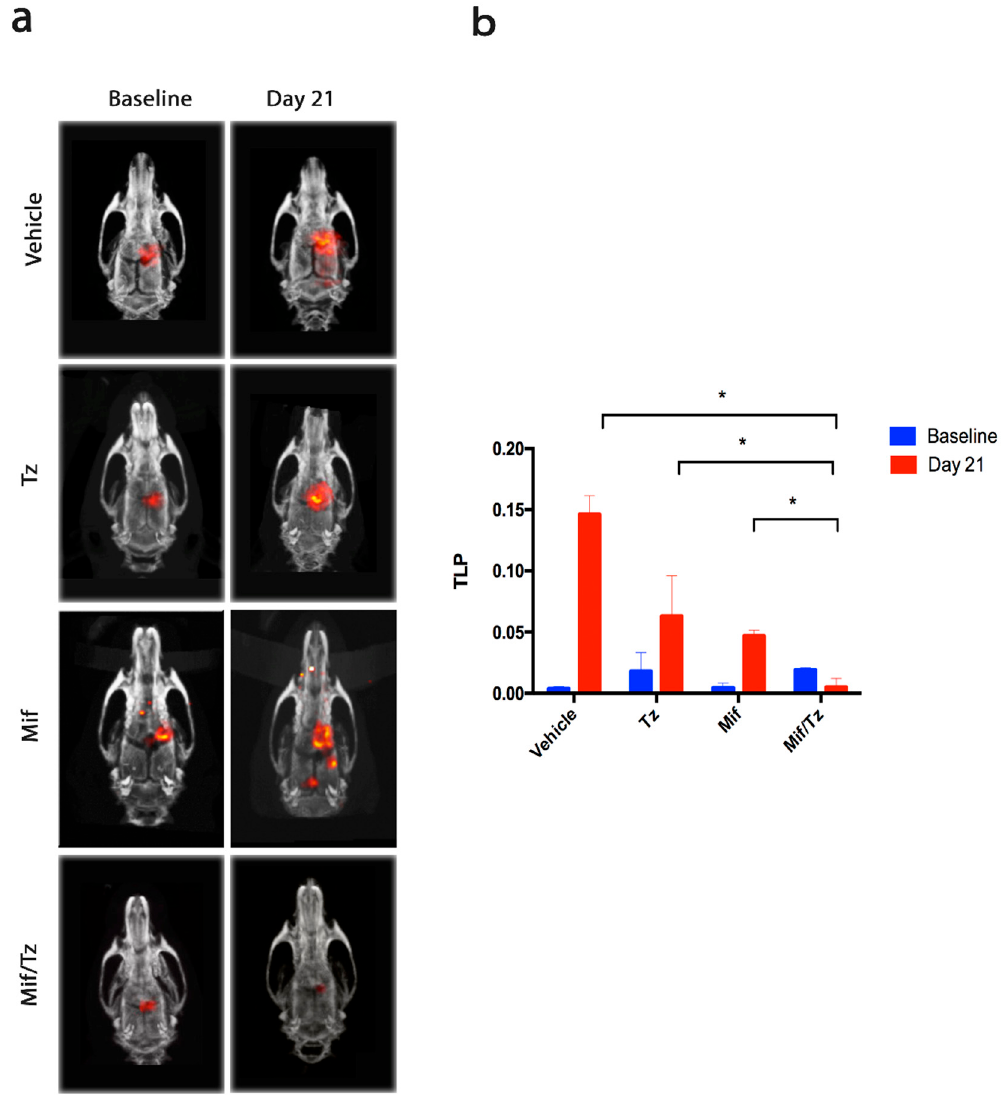
Figure 1. Antitumor activity in the orthotopic rat model of a glioma. ( a ) PET/CT images showing 18 F-FLT ( 18 F-fluorothymidine) tumor uptake for the distinct groups. The images on the left represent the beginning of drug treatment (baseline, two weeks after tumor cell implantation, considered as day 0) and those on the right depict the end of the third week of treatment (day 21). Red reflects the uptake of ( 18 F-FLT). ( b ) The proliferative activity of tumors, measured as total lesion proliferation (TLP). Data are expressed as the mean ± SEM of three animals. * A significant difference ( p < 0.05) between the Mifeprostone/Temozolomide (Mif/Tz) group and the other groups with implantation of glioma cells (the vehicle only, Tz only and Mif only).